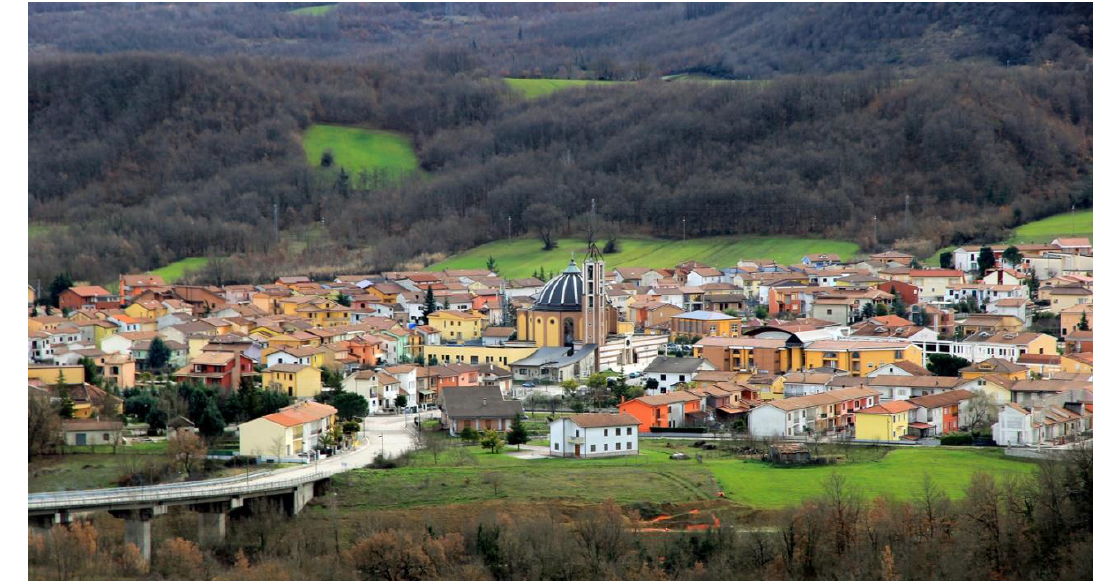
Figure 18. Conza della Campania: panoramic view of the new Conza built in Piano delle Briglie locality, 4 km far from the original nucleus of the old Conza (photos by [35,36]).